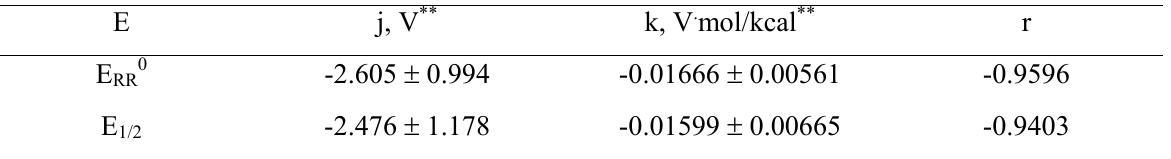
Table 2c. Correlations of standard potentials of reductive dimerization (E RR0 ), semineutralization ) ( vs saturated Hg potentials (E 1/2